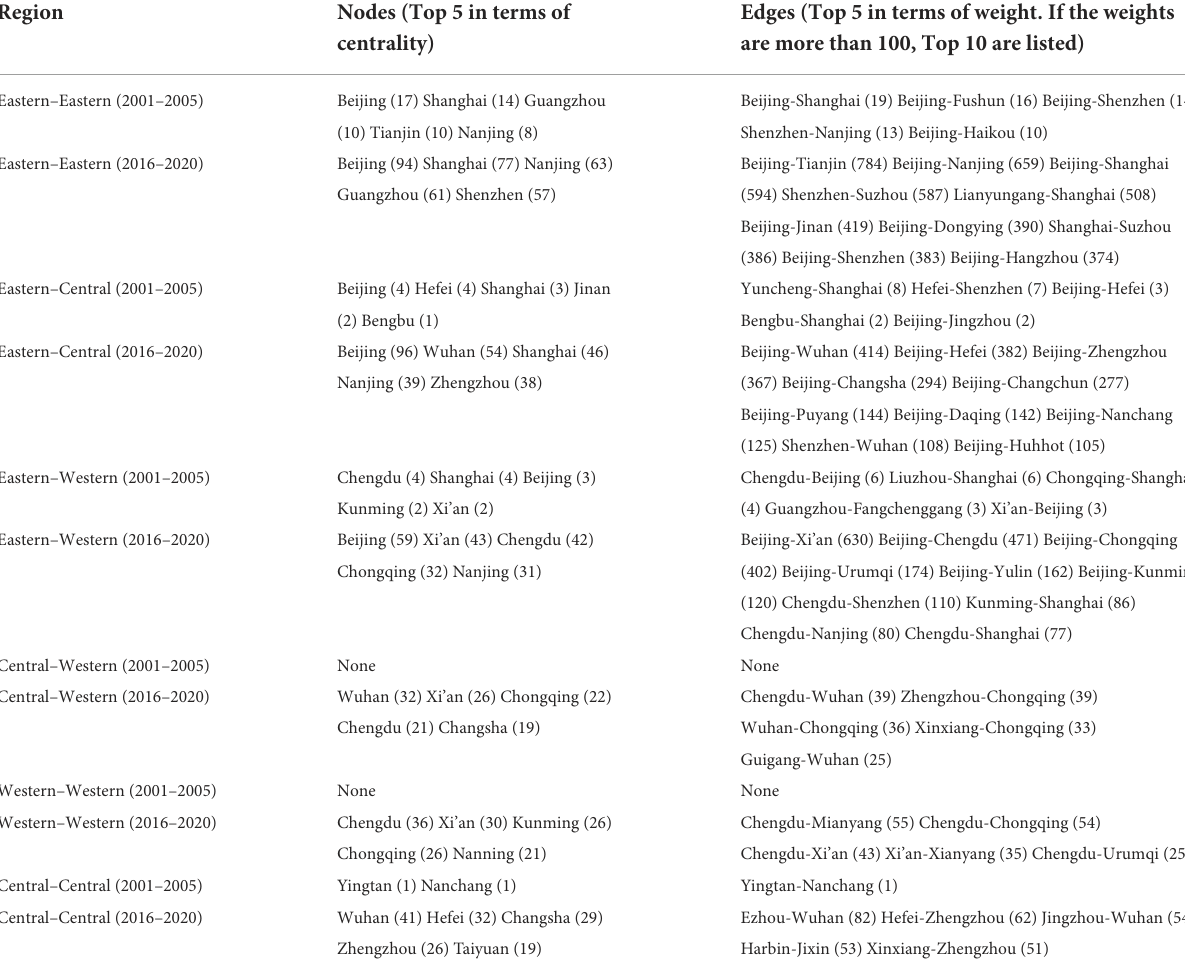
TABLE 4 Spatial pattern of the Chinese urban biomedicine innovation network on the interregional scale in the 2016–2020 period. Region Nodes (Top 5 in terms of Edges (Top 5 in terms of weight. If the weights centrality) are more than 100, Top 10 are